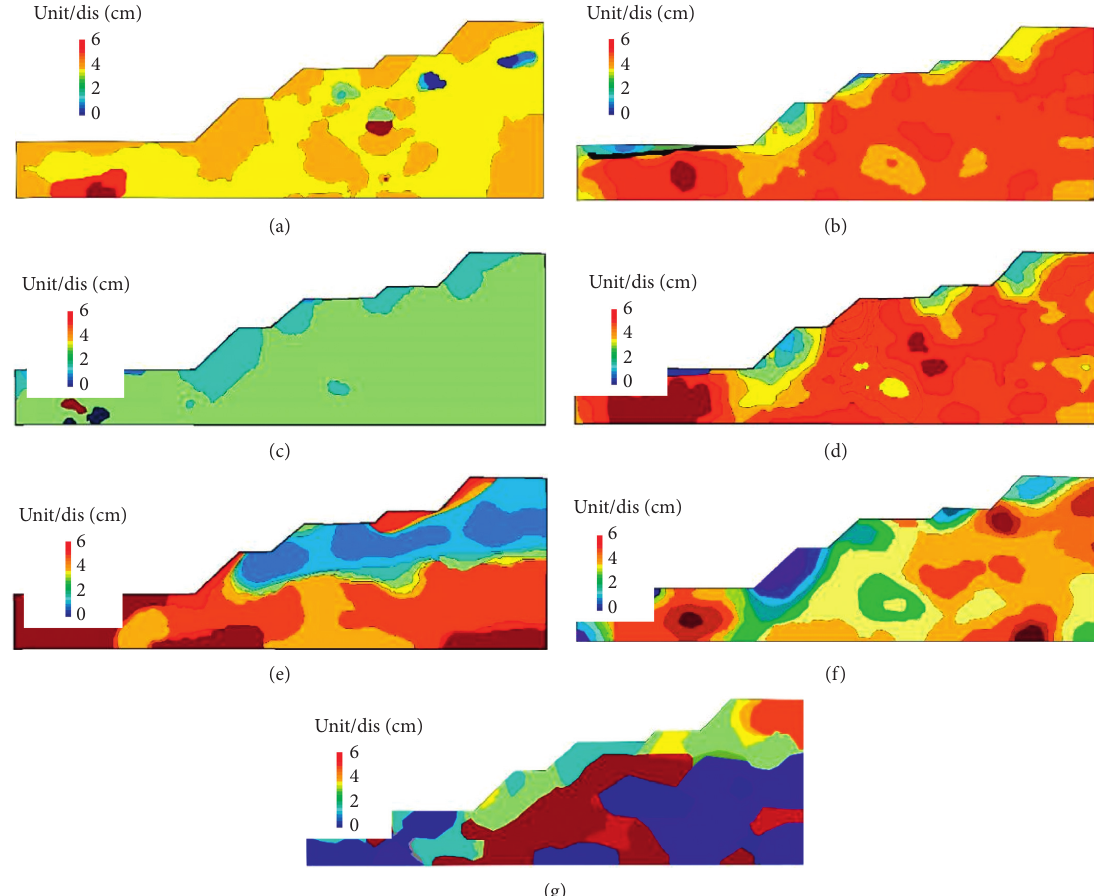
Figure 4: Horizontal displacement nephograms at different frequencies in the x -direction. (a) 15Hz. (b) 20Hz. (c) 25Hz. (d) 30Hz. (e) 35Hz. (f) 40Hz. (g)